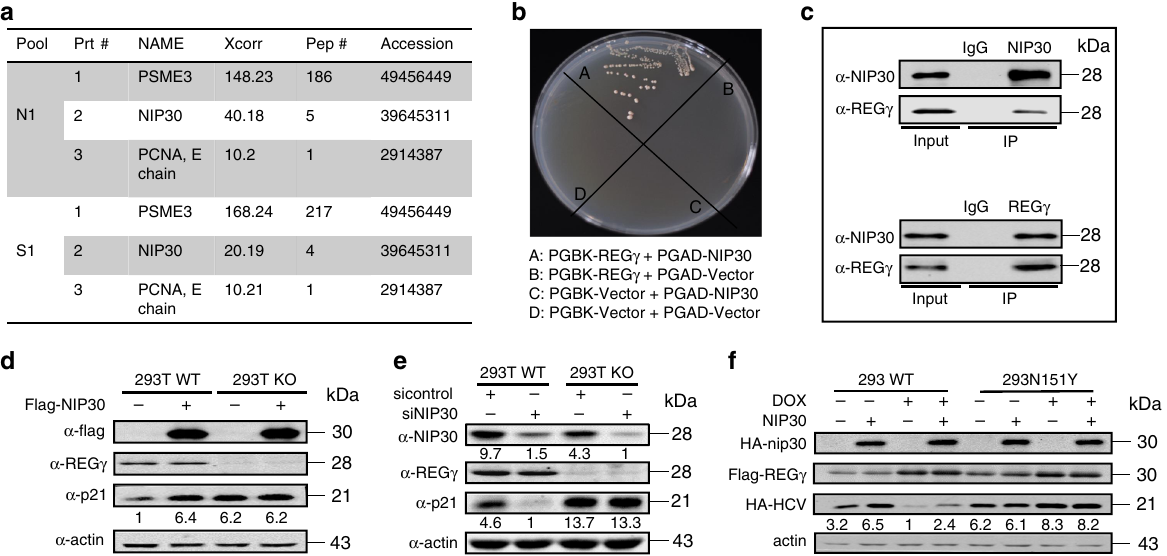
Fig. 1 NIP30 interacts with REG γ and antagonizes REG γ -mediated degradation of p21. a Mass spectrum analysis of proteins co-immunoprecipitated with Flag-REG γ stably expressed in 293T cells. N1 stands for a nuclear fraction; S1 refers to a cytoplasmic fraction. b Yeast two-hybrid assays demonstrated physical interactions between NIP30 and REG γ . c Intracellular interactions between REG γ and NIP30 in 293T cells determined by reciprocal